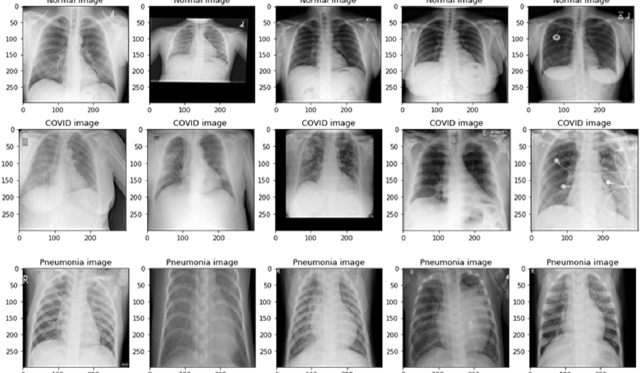
Fig. 1. Five sample images of normal lung, COVID-19 cases, and pneumonia